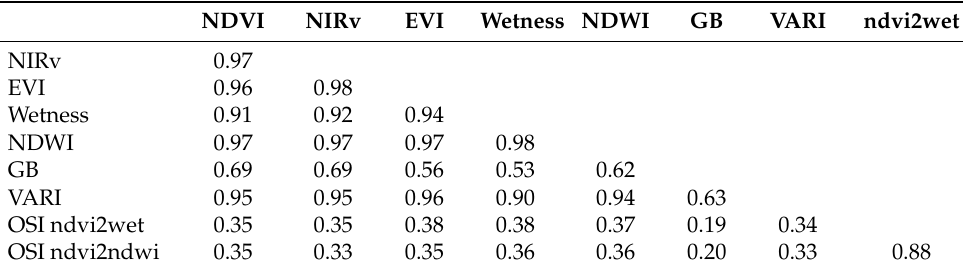
Figure 4. Correlation values between the LAI and the spectral indices ( A ) and the OSI combinations ( B ). Table 3. Correlation coefficients among the spectral indices (n =